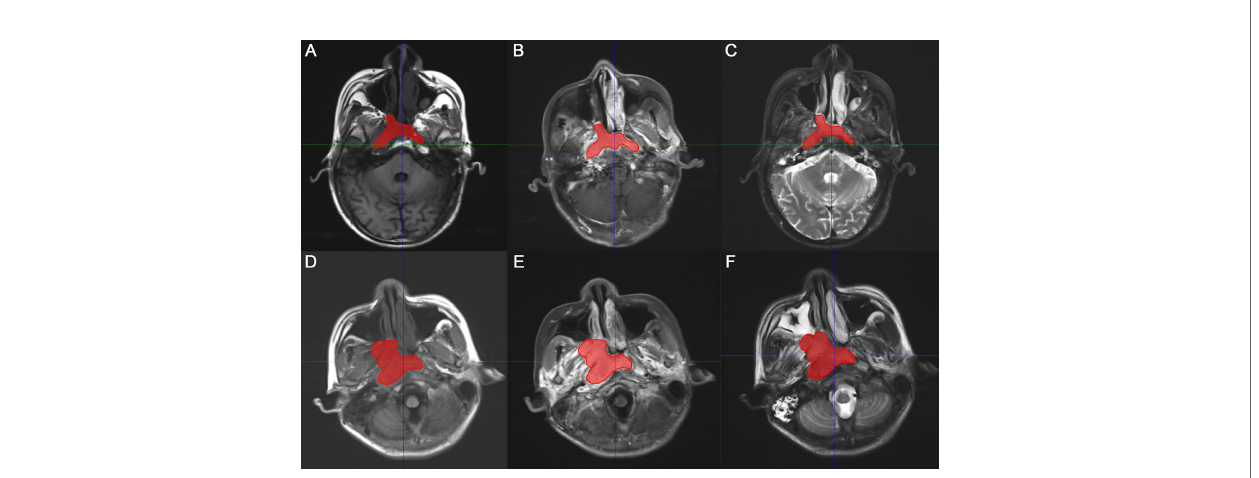
FIGURE 2 | Representative two examples of contoured gross tumor volume (GTV) on multiple-sequence MRI. (A, D) T1-weighted, (B, E) T1 contrast, (C, F) T2- weighted MRI for patient 1 and 2,